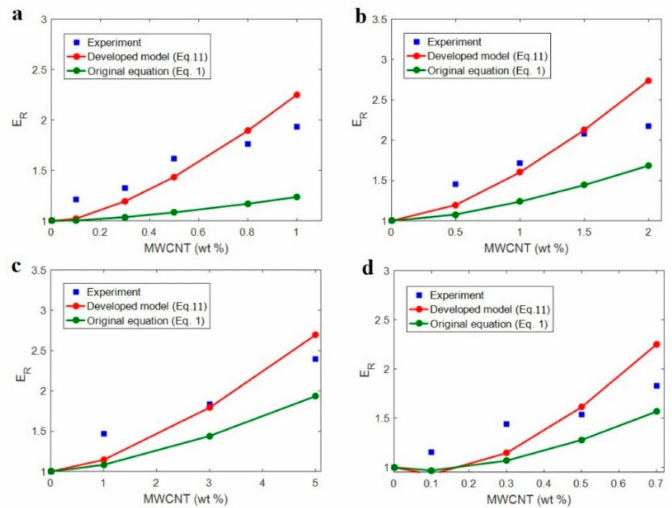
Figure 2. The experimental data of relative modulus and the calculations of original and developed models for ( a ) chitosan / MWCNT [45], ( b ) PP / MWCNT [46], ( c ) PVA / MWCNT [47] and ( d ) epoxy / MWCNT [17]